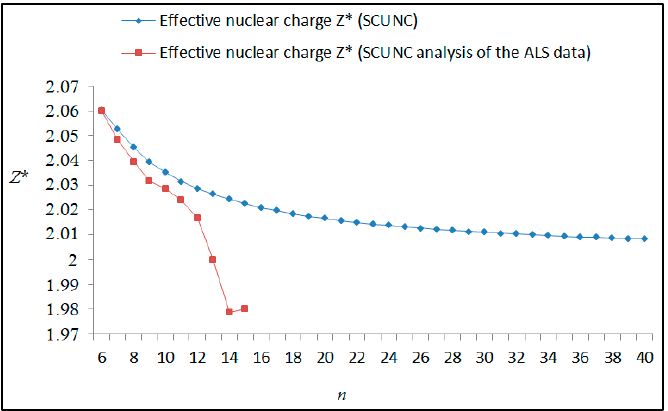
Figure 10. Variations of the effective nuclear charge Z* with the principal quantum number n for the 4 s 2 4 p 2 ( 1 D 2 ) nd ( 2 P 1/2 ) Rydberg series originating from the 2 P ° 1/2 metastable state of Se + converging to the 2 D 1 series limits in Se 2+ . ** Energy differences relative to the ALS experimental data. Table 6. Energy resonances ( E ), quantum defect ( δ ) and effective charge ( Z *) of the 4 s 2 4 p 2 ( 1 D 2 ) nd ( 2 S ) Rydberg series originating from the 4 s 2 4 p 3 2 P ° 1/2 metastable state of Se + converging to the 3 P 2 series limit in Se 2+ . The present results (SCUNC) are compared with the experimental data from ALS measure- ments [6]. The uncertainties in the experimental energies are stated to be ±0.010 eV, f 1 ( 1 D 2 ; 2 S ; 2 P ° 1/2 ) = − 0.165 ± 0.033 with ν = 6.